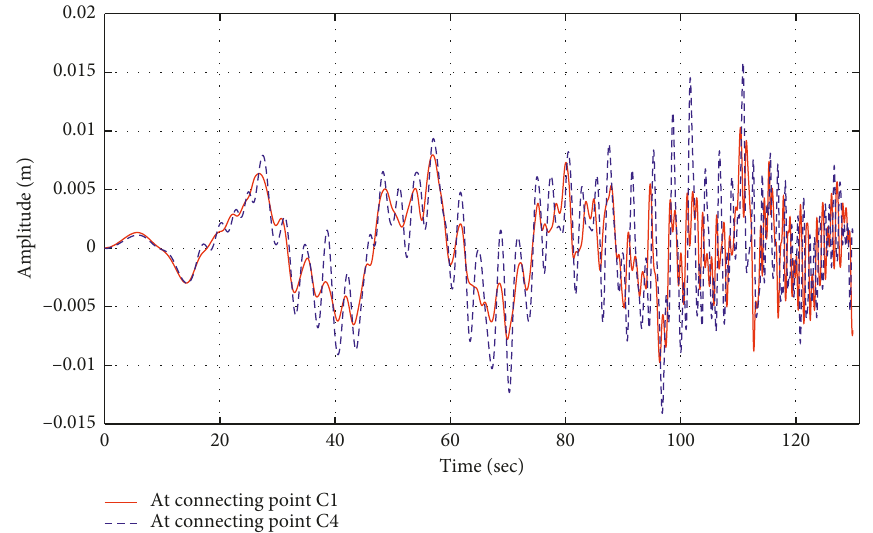
Figure 27: Comparison of the transverse vibrations of the traction system at the connecting